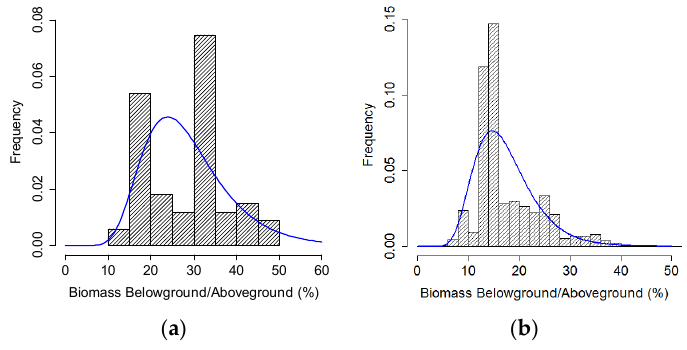
Figure 4. The distribution of biomass ratio between belowground and aboveground: ( a ) deciduous with log-mean of 3.3 and log-STD 0.3; and ( b ) evergreen with log-mean of 2.8 and log-STD 0.3.